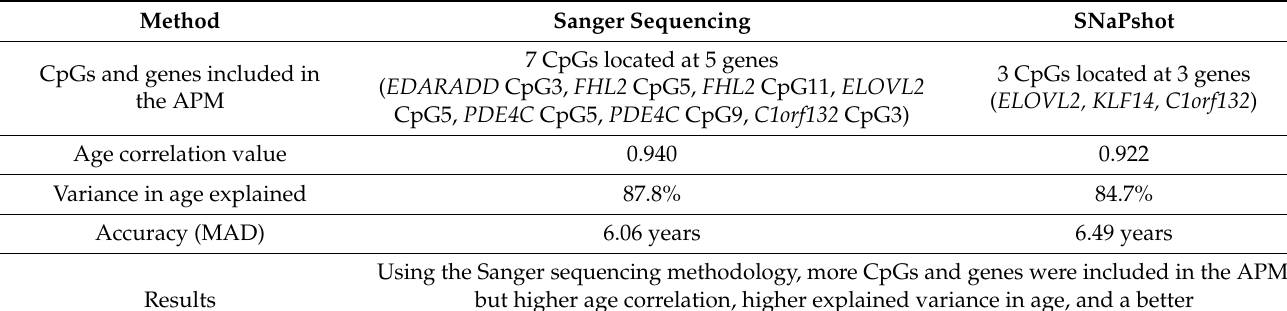
Table 4. Comparison between Sanger sequencing and SNaPshot